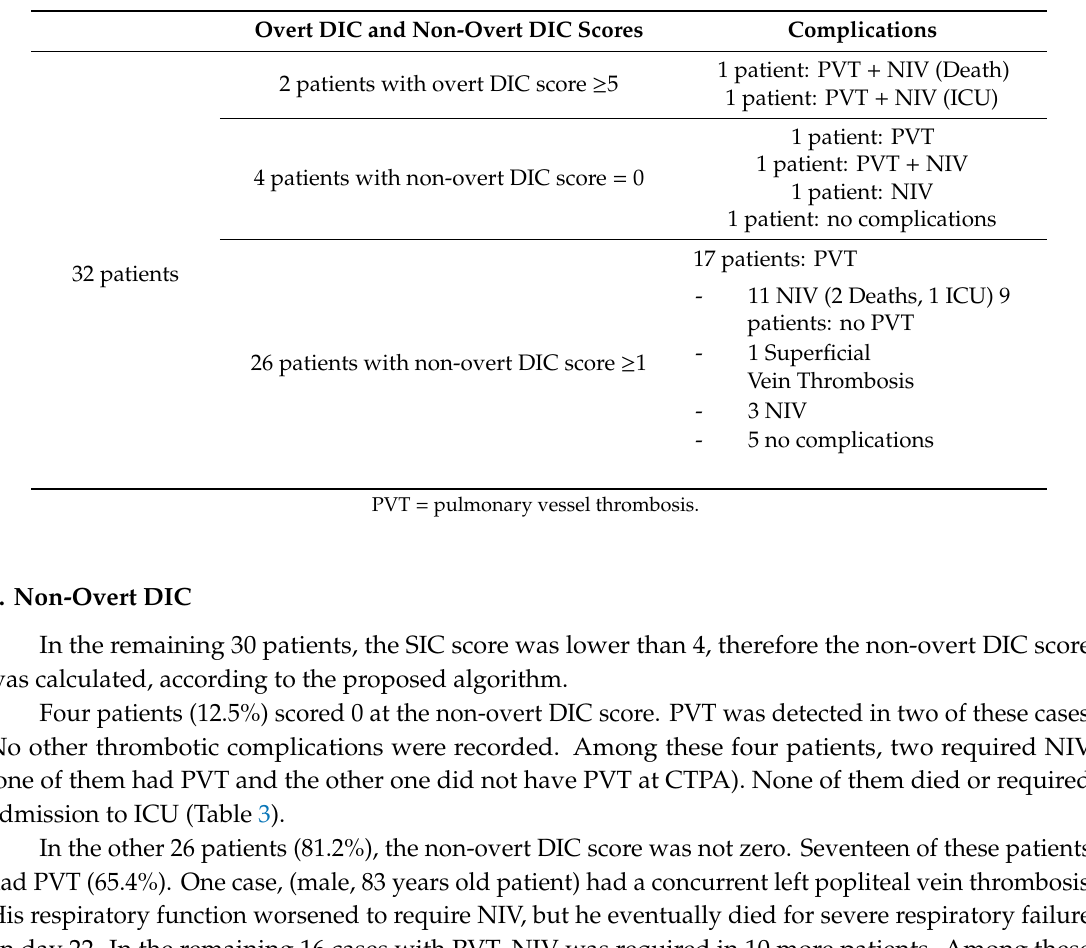
Table 3. Occurrence of death, thrombotic complications, and need for non-invasive ventilation (NIV) and intensive care unit (ICU) admission for the patients of the case series, according to the results of the overt and non-overt disseminated intravascular coagulation (DIC) scores. Overt DIC and Non-Overt DIC Scores Complications 2 patients with overt DIC score ≥